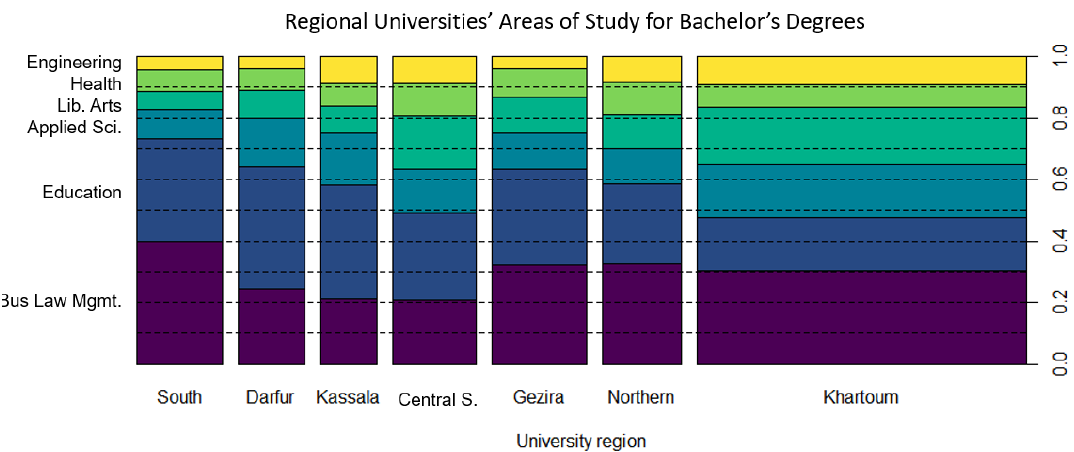
Figure 24. Spine plot of departmental enrollments (by category) by university region for bachelor’s students (2016–2017).